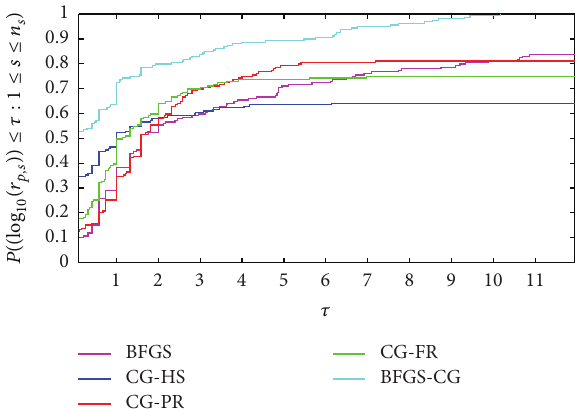
Figure 2: Performance profile in a log 10 scale based on CPU